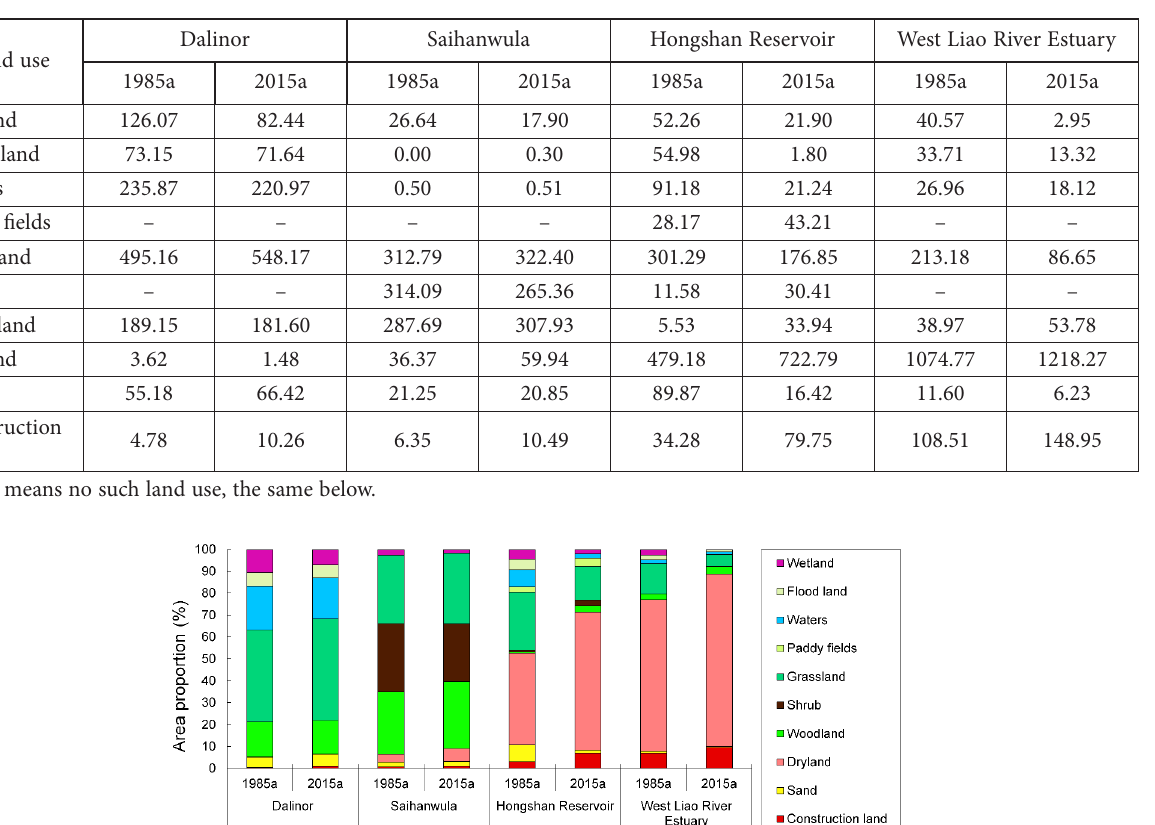
Table 1. Changes in land use in each study area (km 2 )